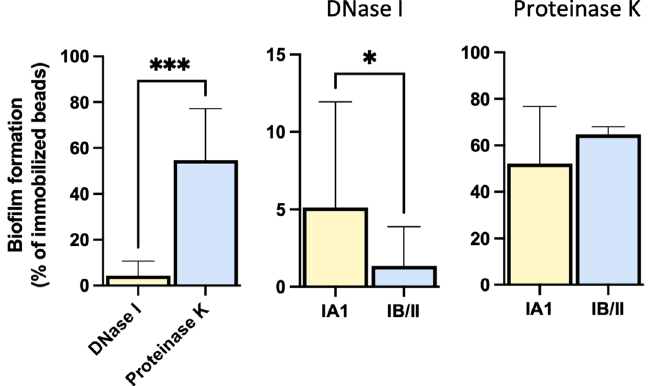
Figure 5. DNase I and Proteinase K reduce C. acnes adhesion. Comparison of extracellular DNA and proteins on early surface adhesion for the IA1 and IB/II phylotypes. Results are expressed as relative differences (Eq. 1) in the amounts of biofilm as measured by the BioFilm Ring Test after 6 h of incubation in the presence of DNase and Proteinase K compared with untreated control strains. Data represent means and the corresponding standard errors of two independent experiments analyzed in duplicate; *, P < 0.05; **, P < 0.01; ***, P < 0.001, ****, P < 0.0001 using the Mann–Whitney test.